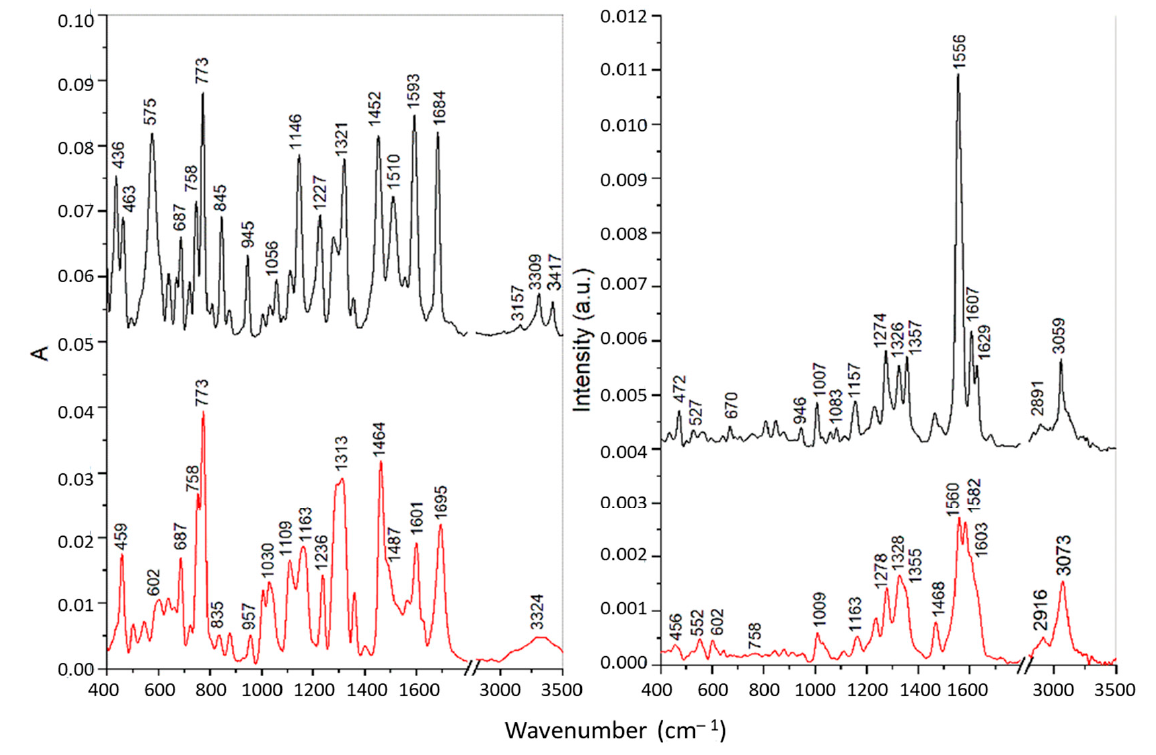
Figure 5. FTIR ( left ) and Raman spectra ( right ) of the T8H-TSC receptor (black) and its complex with Cu(II) ions (red).